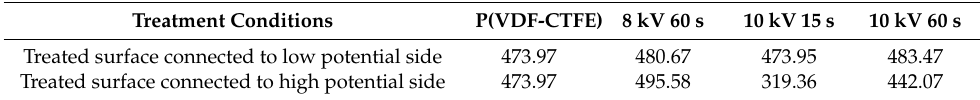
Table 1. The dielectric breakdown strength of the pristine P(VDF-CTFE) film and the film treated under di ff erent conditions (Unit: MV /